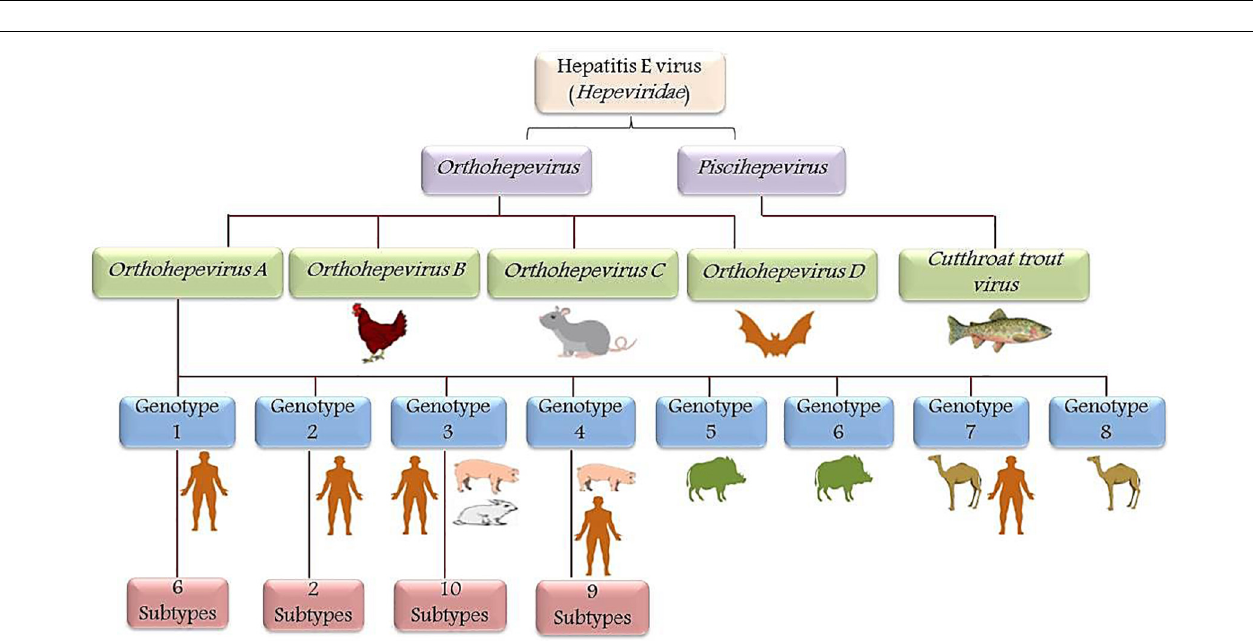
FIGURE 1 | Genomic organization of HEV: Classically divided into three ORFs (ORF1, ORF2, and ORF3) except genotype-1 having an additional ORF4. HEV RNA is transcribed into subgenomic RNA of ∼ 3.7 and ∼ 2 kb. The 5 (cid:48) non-coding region is capped with 7-methylguanosine (7mG) and 3 (cid:48) is polyadenylated [poly(A)]. ORF1 encodes for non-structural proteins including MT, regions of unknown function (Y, PPR, and X), Pro, Hel, and Pol or RdRp. ORF2 codes for capsid protein and ORF3 is a multifunctional protein that helps in the release of virions from the infected cell.